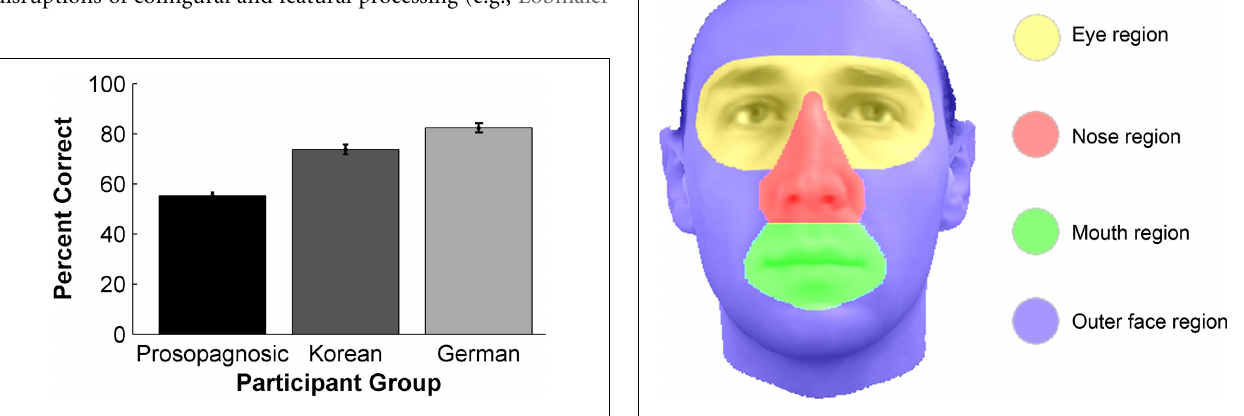
FIGURE 2 | Illustration of the editable regions of the 3D faces of our in-house face database (Troje and Bülthoff,